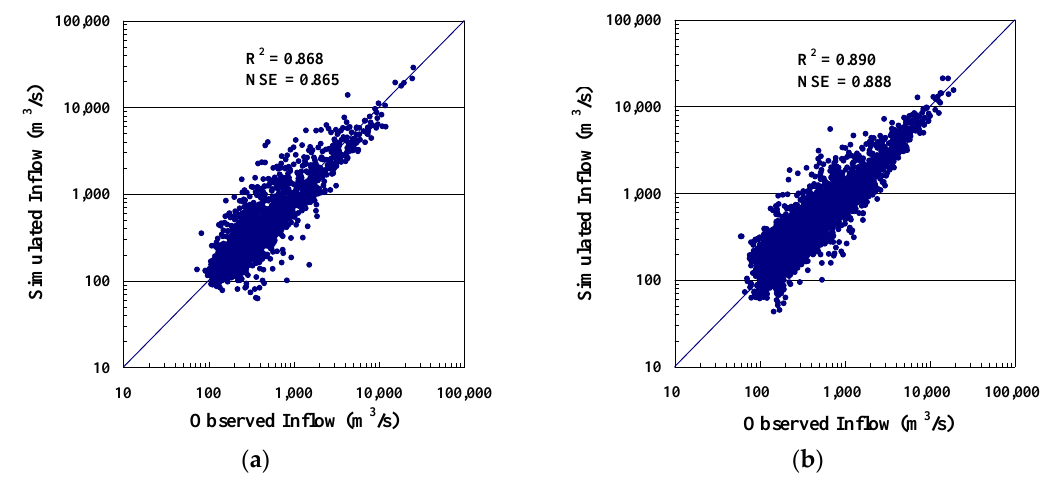
Figure 3. Comparison of the observed and simulated inflows to the Paldang Dam for ( a ) calibration period (1986–1995) and ( b ) validation period (1996–2015).